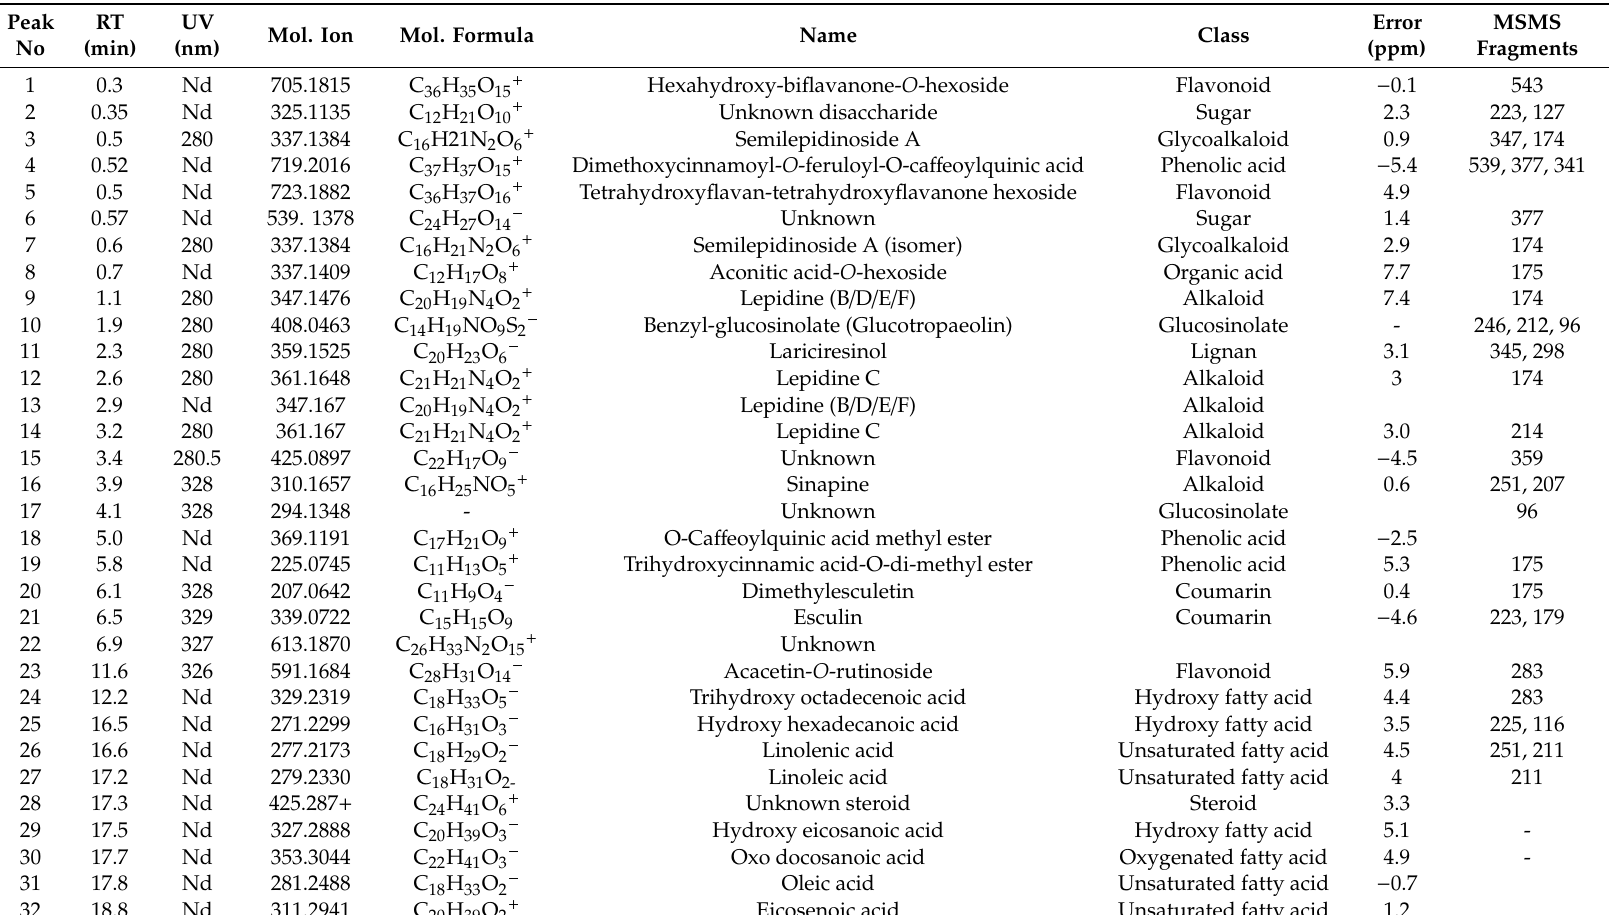
Table 2. Metabolites identified in 100% methanol extracts of L. sativum seeds via UHPLC-PDA-ESI-MS in both negative and positive ionization modes. Nd = not detected, + or – denotes molecular ion charge in molecular